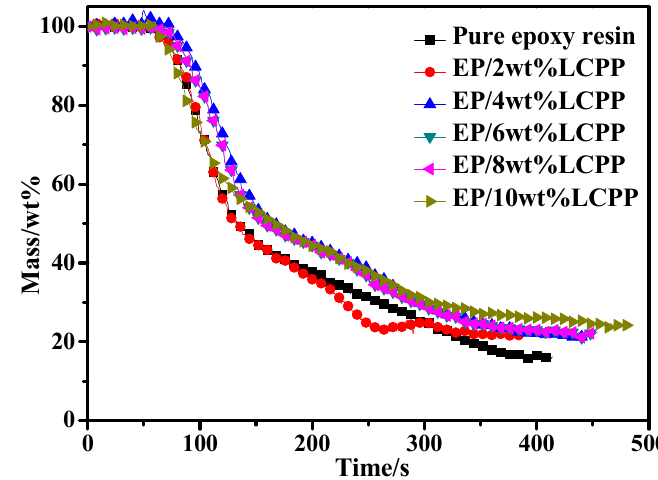
Figure 5. Mass loss curves of EP and the EP/LCPP composites.